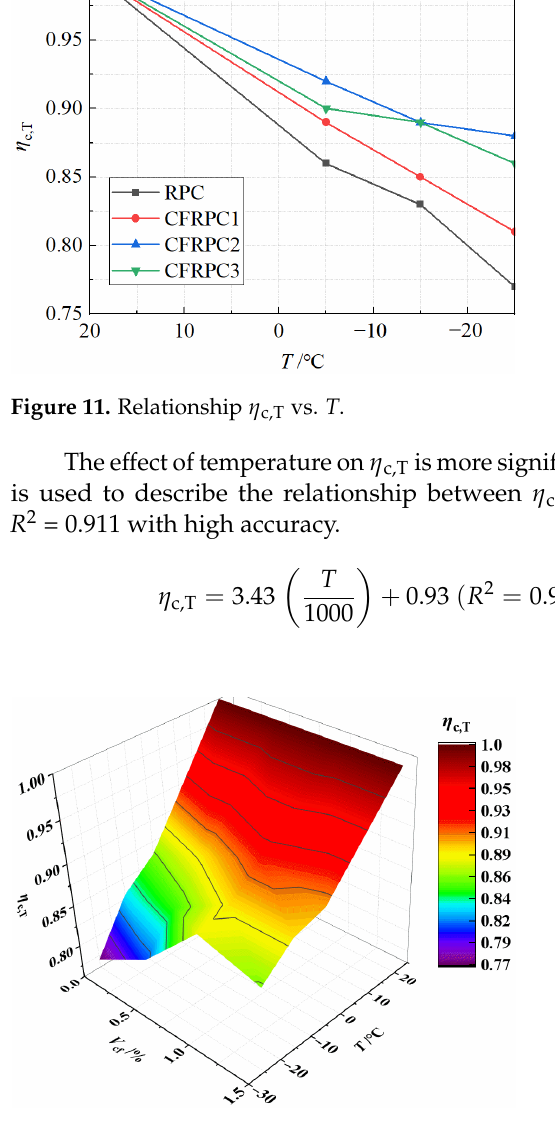
Figure 12. Relationship